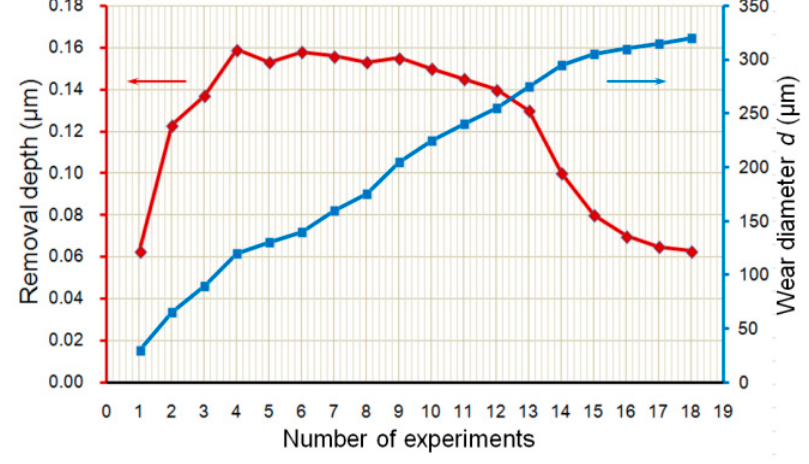
Figure 14. Relations of the polisher’s wear and material removal depth.